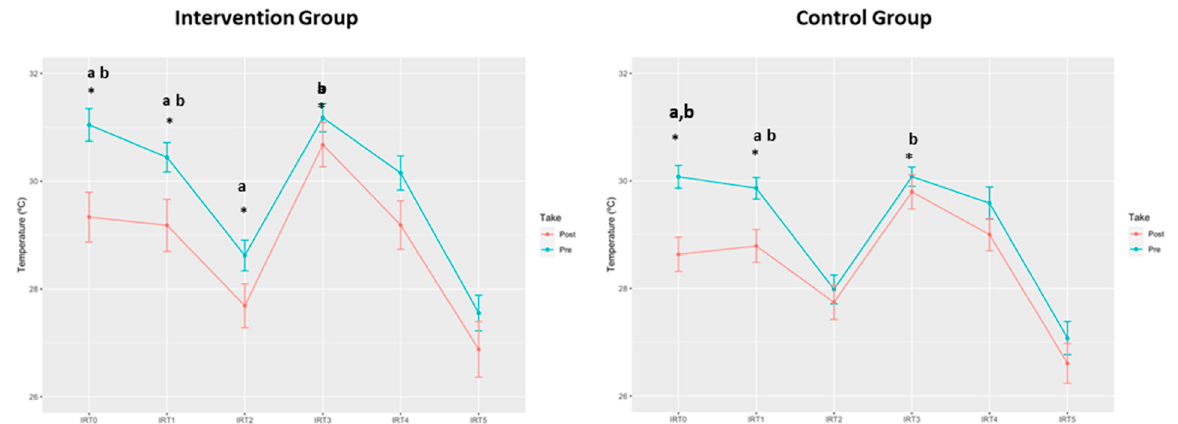
Figure 4. Skin temperature (°C) before (Pre) and after (Post) administration of 2 g of Exten(d) for 30 days to volunteers compared to placebo. IRT0 = basal round; IRT1 = after acclimation to room temperature; IRT2 = after first biomechanical running test; IRT3 = shortly before incremental test to exhaustion; IRT4 = immediately post-incremental exercise test to exhaustion; IRT5 = after cooling down. * p < 0.05; a = intragroup; b = intergroup (Pre).